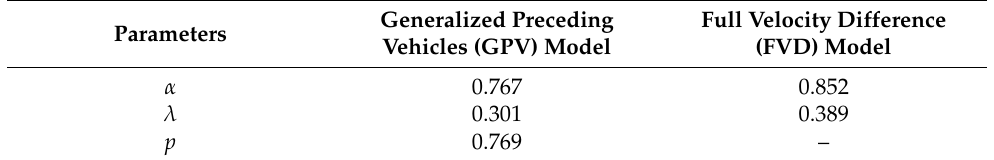
Table 2. Parameters value in Equation (4) [33].